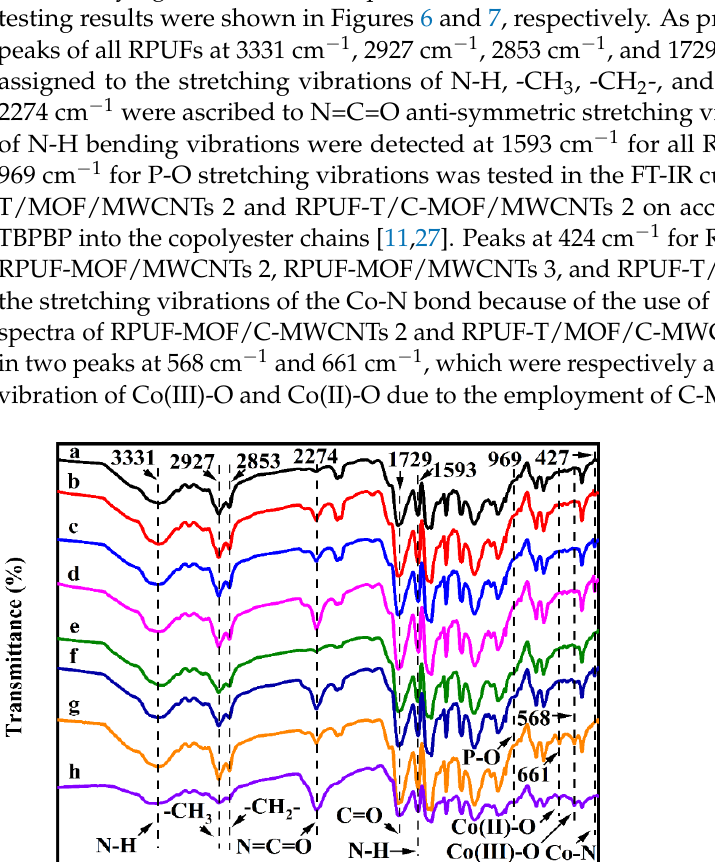
Figure 5. TGA curves of C-MOF/MWCNTs under N 2 and air ( a ), and DTG curves under N 2 and air ( b ).